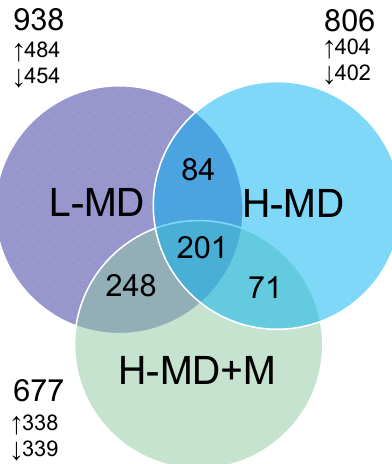
Figure 2. Venn diagram depicting unique and shared (overlapping circles) sets of differentially expressed genes (DEGs) in male offspring exposed to a methyl-deficient diet (L-MD, purple circle), high methyl-donor diet (H-MD, blue circle), and high methyl-donor diet plus melatonin therapy (H-MD+M, green circle). A total of 201 DEGs are shared by three groups. The total number, as well as number of up- or down-regulated genes identified during each group, is also indicated. We next used DAVID v6.8 KEGG Pathway tool to identify biological processes from our gene lists. We found 10, 21, and 8 significantly related KEGG pathways in the kidney of the L-MD, H-MD,